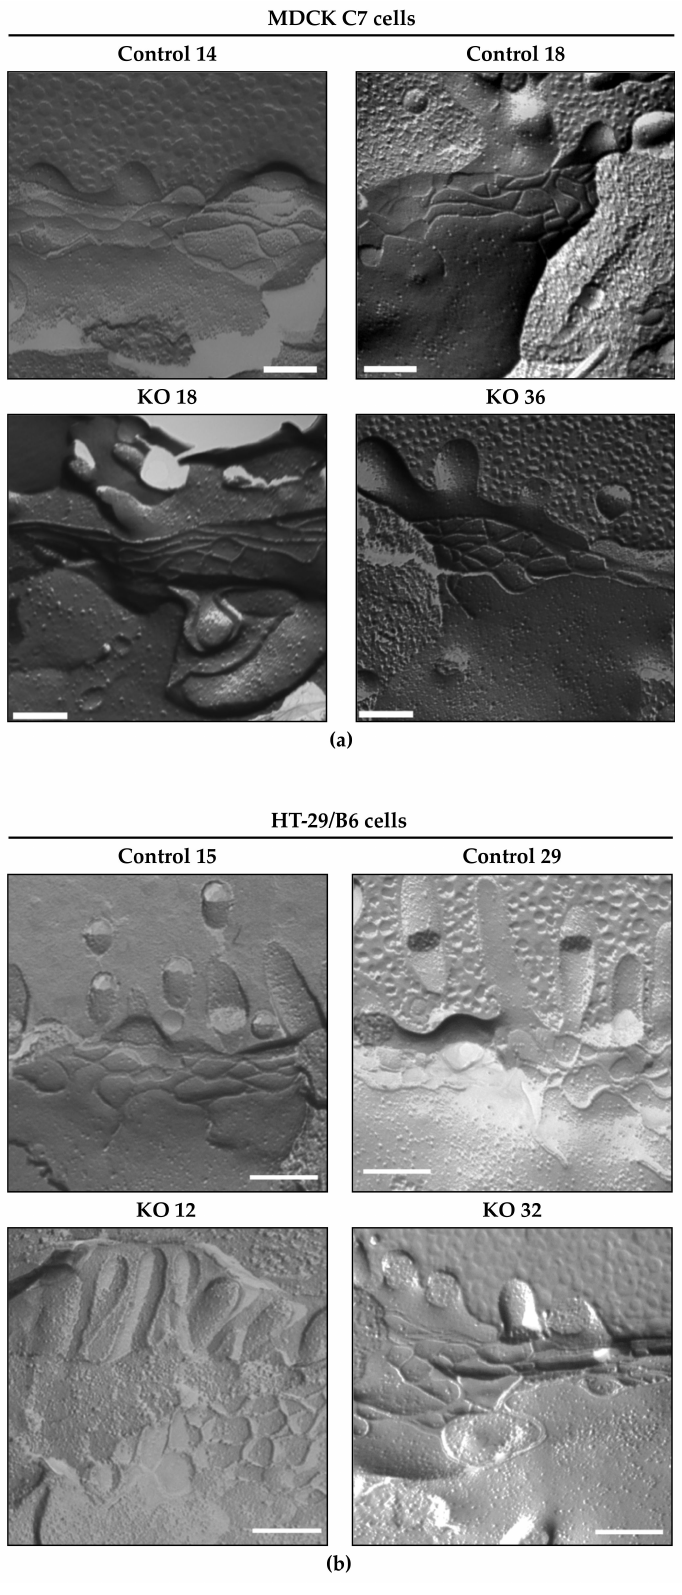
Figure 4. Freeze-fracture electron microscopy of angulin-1 knockout in ( a ) MDCK C7 and ( b ) HT-29/B6 cells. Photos were taken at × 51,000; Bars: 200 nm. The bTJ strands of the control cells and angulin-1 KO clones revealed a regular meshwork, characterized by continuous-type areas. bTJs of angulin-1 KO cells showed no ultrastructural difference compared with control clones in both cell